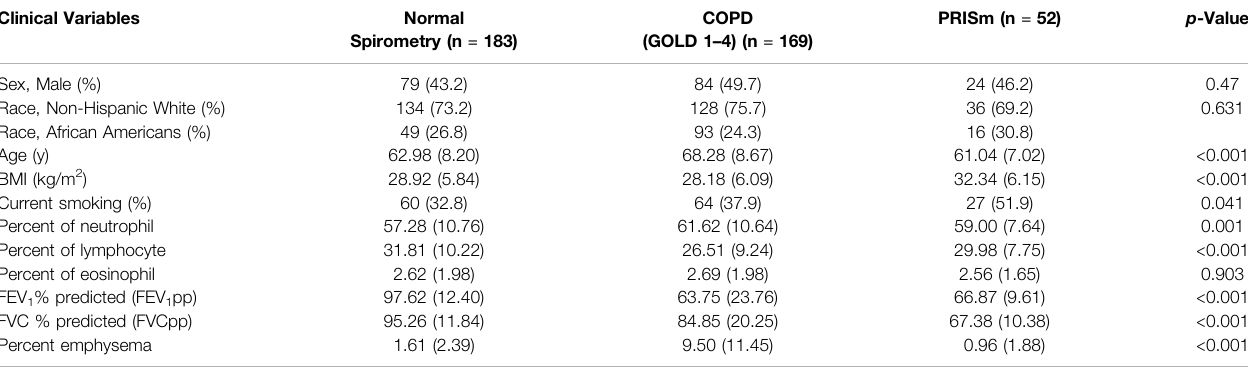
TABLE 1 | Clinical characteristics of overlapping mRNA and miRNA dataset.